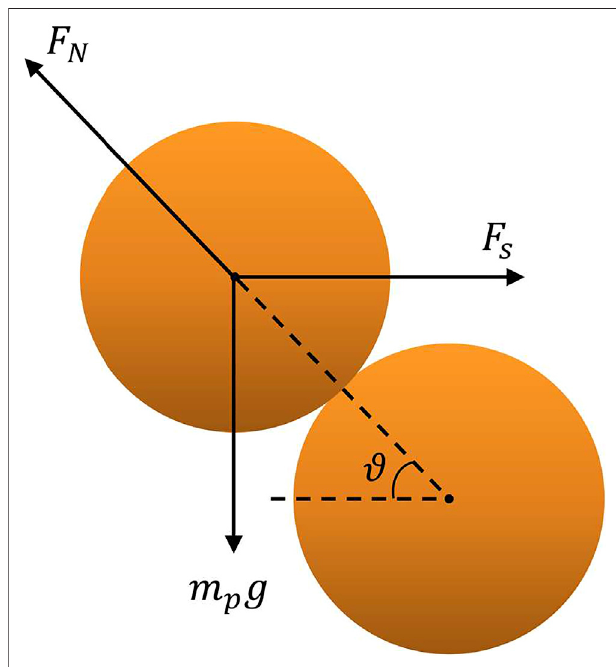
FIGURE 1 | Free-body diagram of a surface particle and its adjacent neighbor exposed to the wind shear